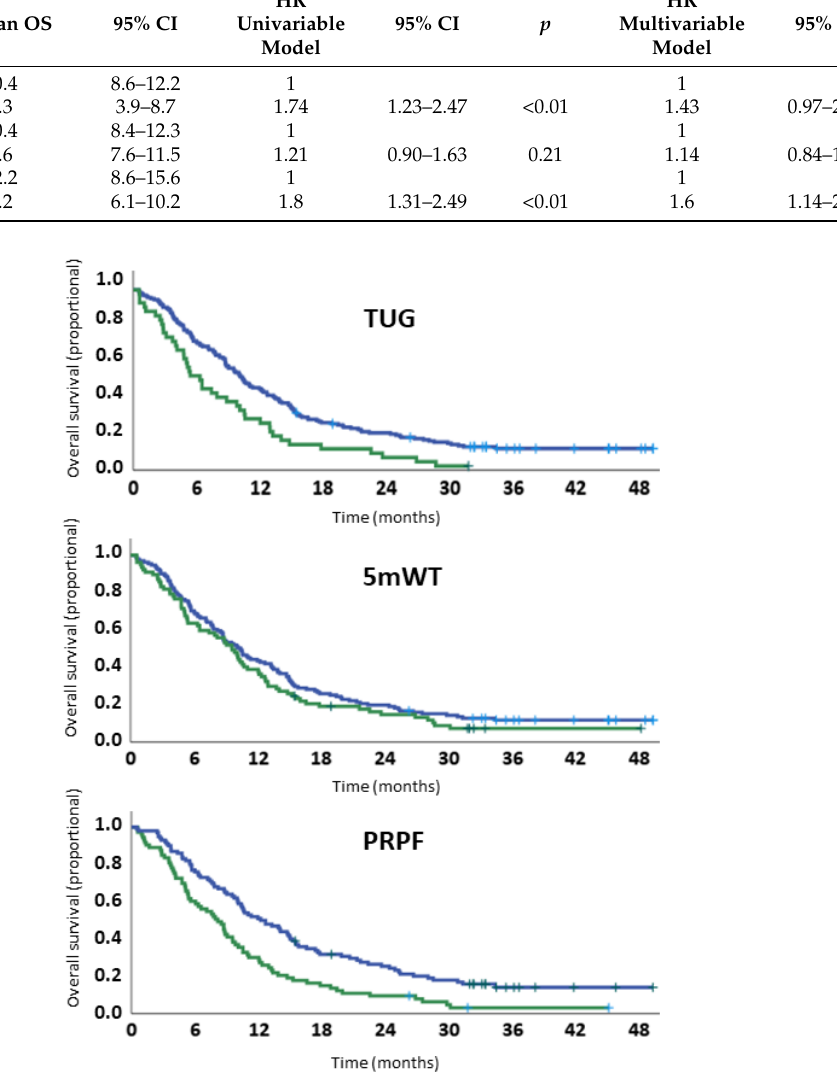
Figure 4. Survival curves according to cutoff values for measured and patient-reported physical function